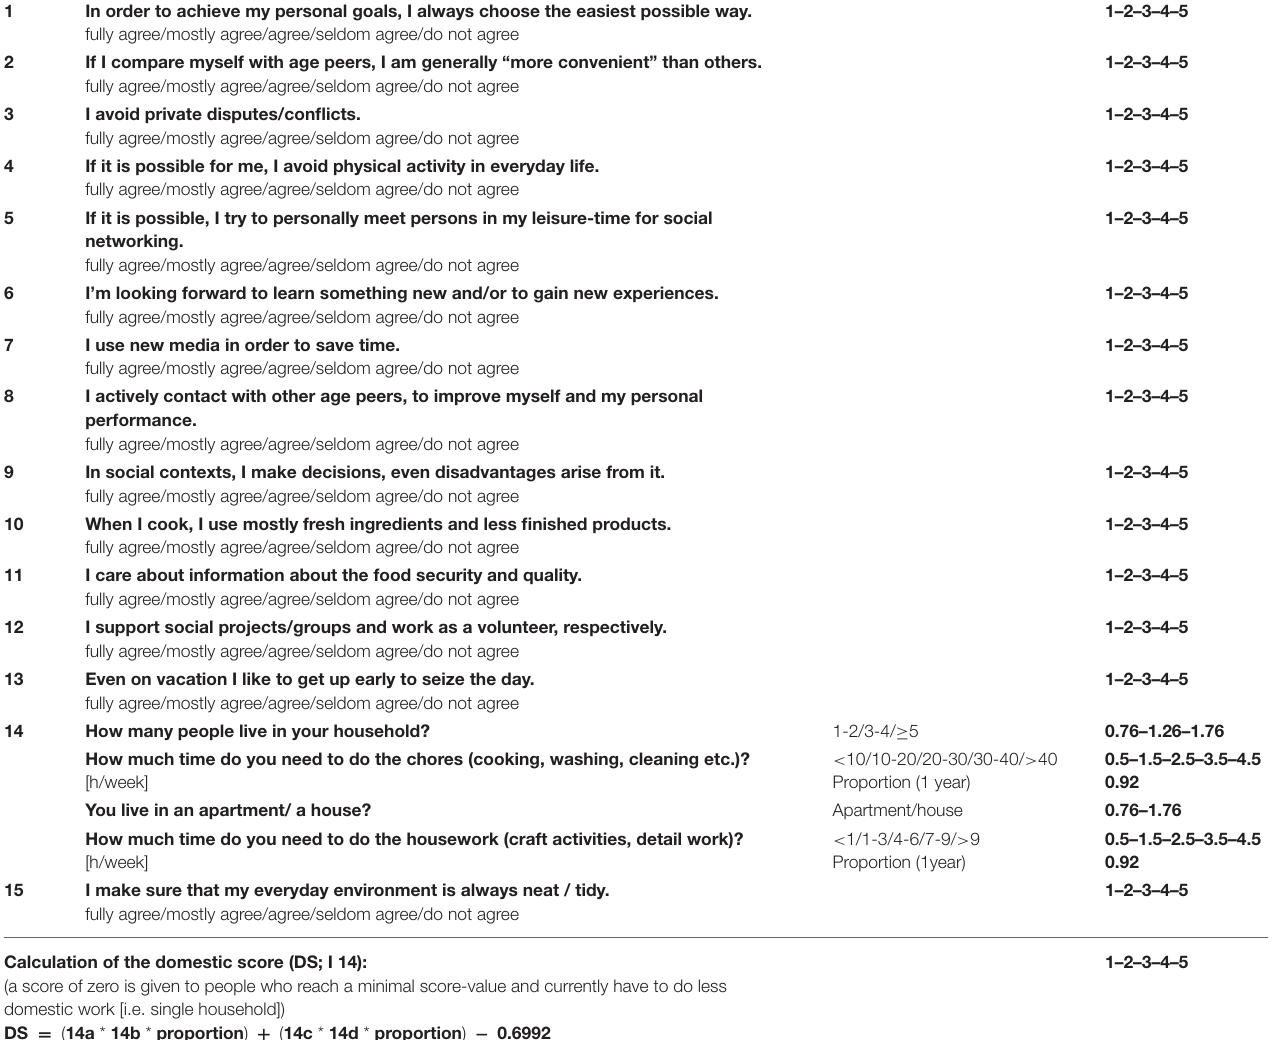
TABLE 6 | Questions, codes, and method of calculation of indices of the Convenience Behavior Questionnaire